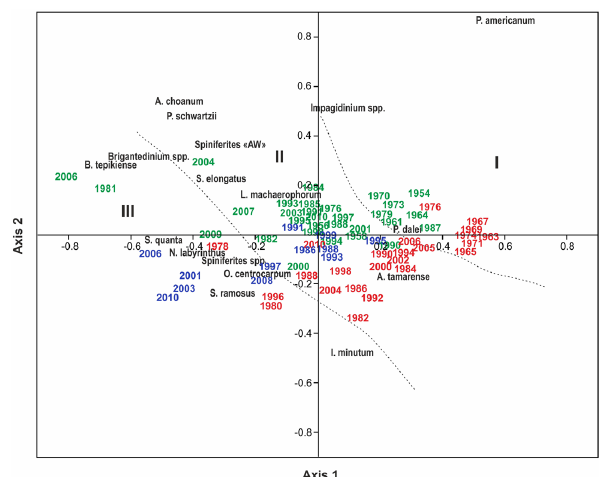
Fig. 4. Correspondence analysis based on relative cyst abundances of all cores combined as one data set. The species are ordinated by the CA according to abundance and downcore variability of cysts. The coloured numbers are organized by sediment cores: MC 61- 1: blue; MC 99-1: red; and MC S4-1: green; samples belonging to group I are placed on the positive axis 1 in correspondence with the dominance of P. dalei , minimum abundances or absence of other taxa; samples categorized into group II are placed mainly in the centre of the CA and are characterized by a successive decrease in P. dalei and consequently higher abundances of most of the other species. Samples representative of group III with the highest cyst evenness are located on the far negative axis